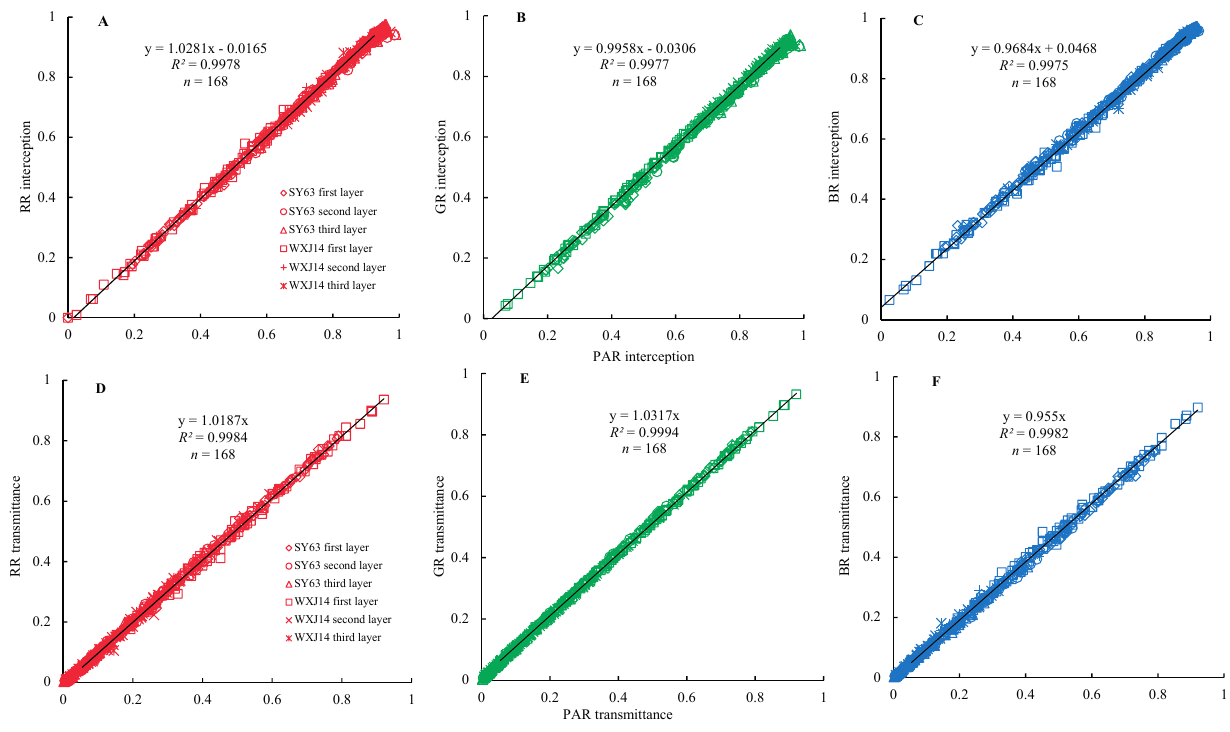
Figure 5. Relationship between transmittance and interception of different wavelengths of light and photosynthetic active radiation (PAR). ( A ) Red radiation interception; ( B ) green radiation interception; ( C ) blue radiation interception; ( D ) red radiation transmittance; ( E ) green radiation transmittance; ( F ) bule radiation